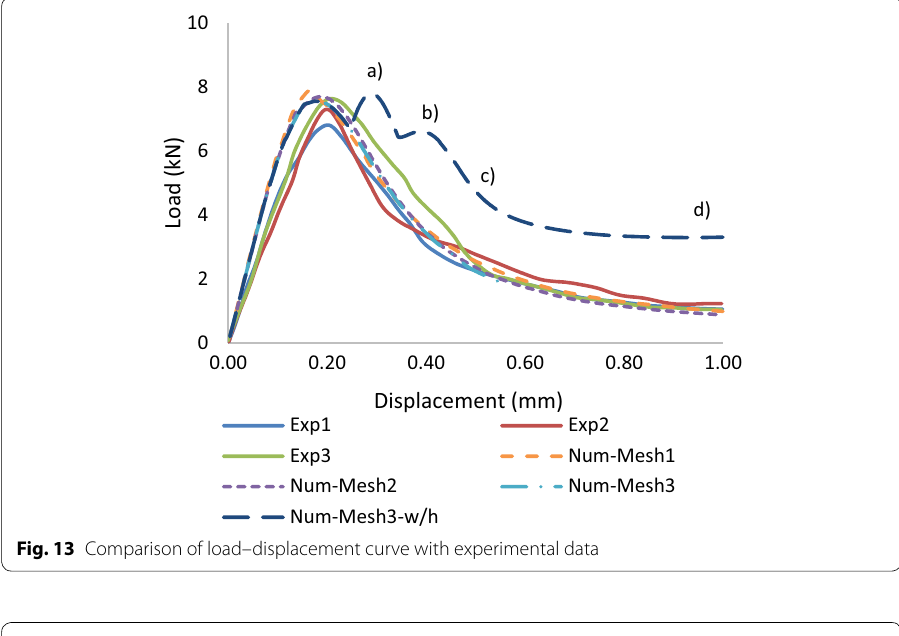
Fig. 13 Comparison of load–displacement curve with experimental data